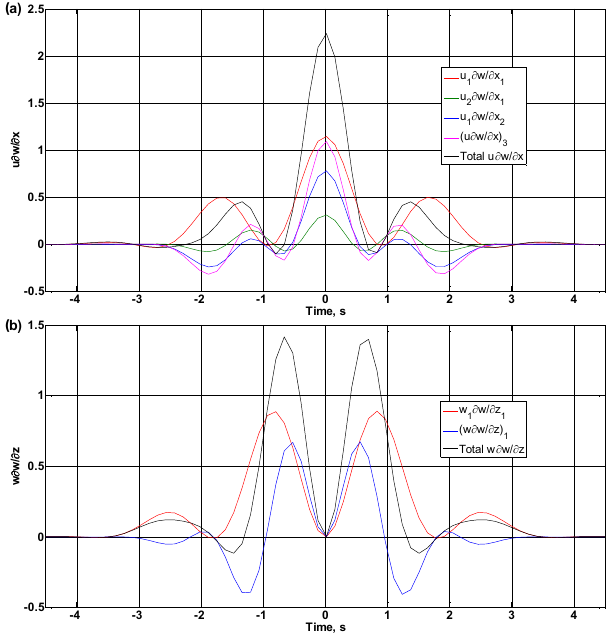
Fig. 4. Terms contribution to the convective vertical acceleration for the conditions of Fig. 3: (a) u . ∂w/∂x ; (b) w . ∂w/∂z